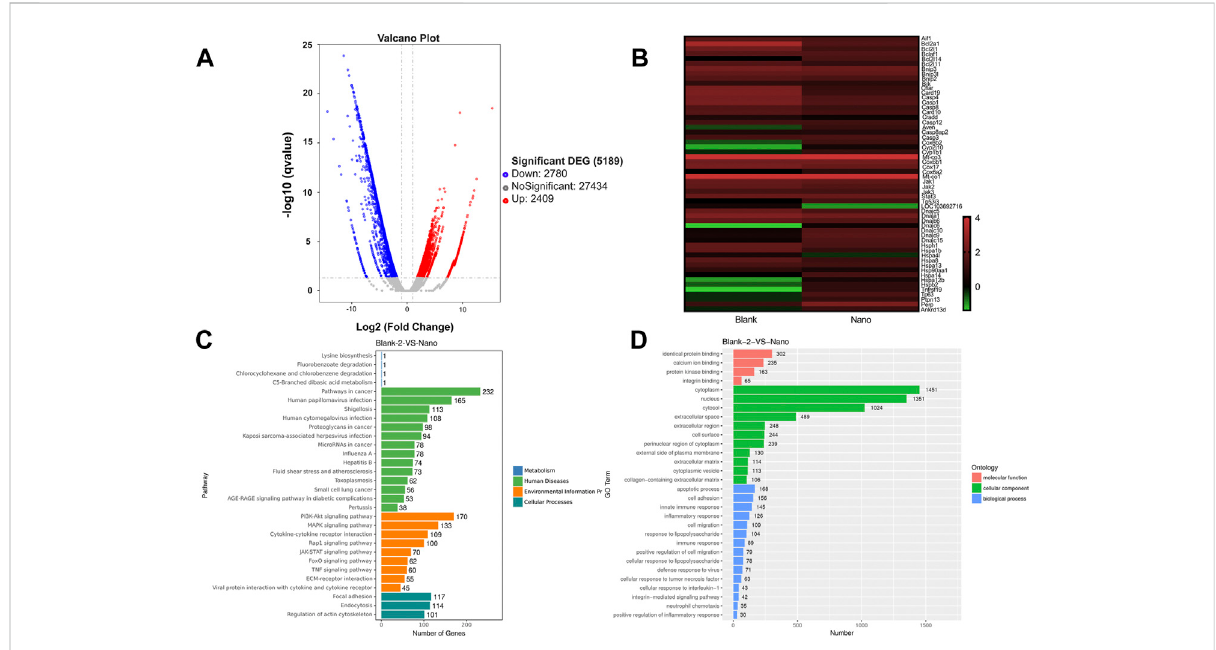
Transcriptomic sequence. (A) Volcano map of TCP and PTX/PCH + NIR. (B) Heatmap of differentially expressed genes in TCP and PTX/PCH + NIR groups. (C) KEGG pathway enrichment. (D) GO terms.